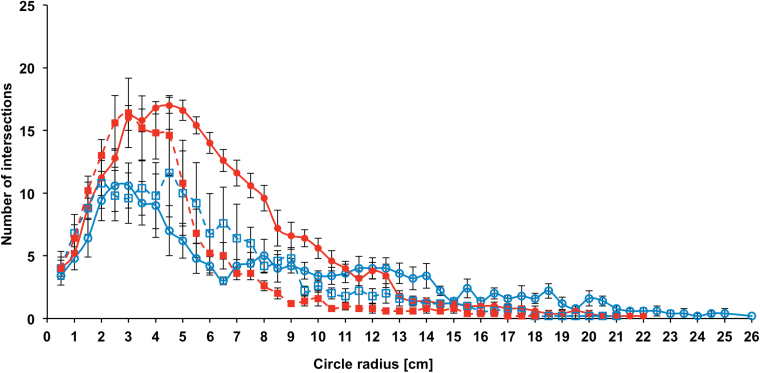
Number of root intersections depending on the distance from root origin of a DR (dotted lines) and a DS (squared lines) winter oilseed rape genotype, measured under control conditions (open symbols) and after 5 days of PEG 6000 treatment (closed symbols). Points are means of five replicates with standard errors (this figure is available in colour at JXB online).